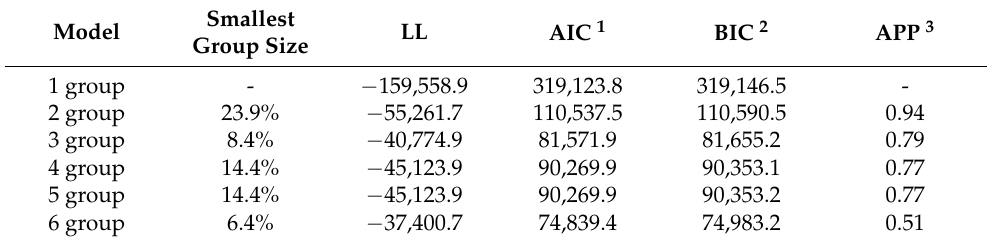
Table 2. The goodness of fit of group-based trajectory analysis sample 2.